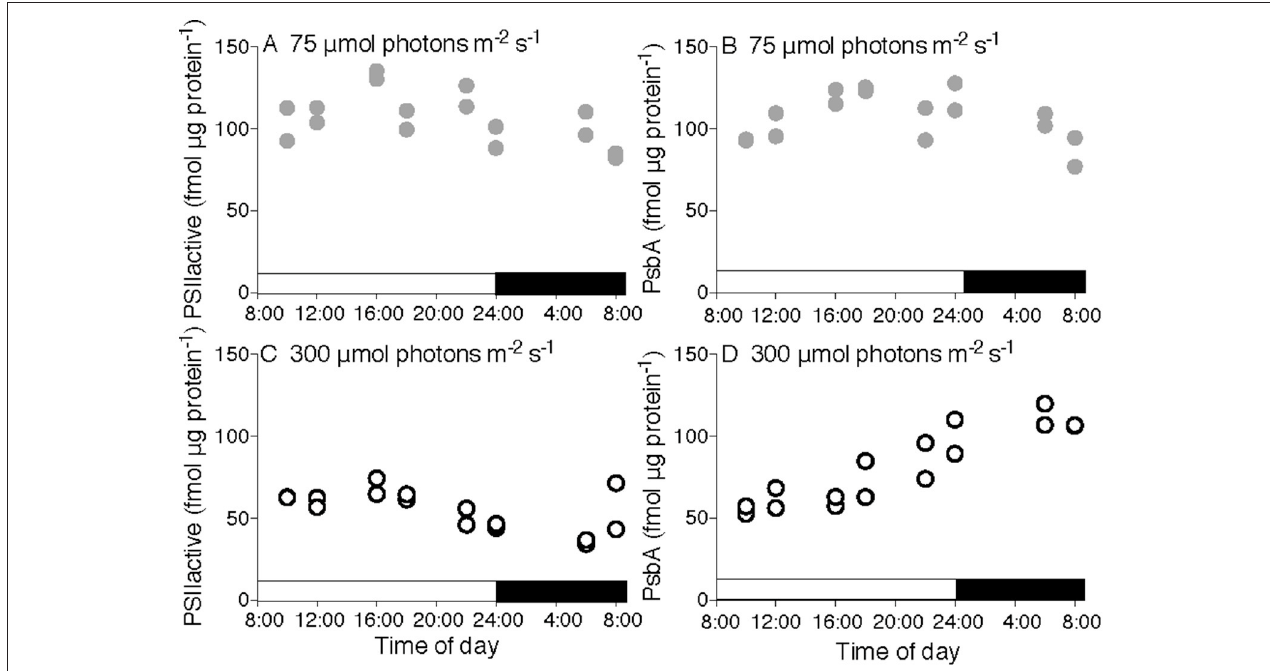
FIGURE 1 | Diel progressions of content of Photosystem II for T. pseudonana . PSII activefluor (A,C) or PsbA protein content (B,D) vs. time of day for cultures growing under 75 (A,B) or 300 µ mol photons m − 2 s − 1 (C,D) with a 16:8 L:D cycle indicated by horizontal bars along X axes. Points show determinations upon two separate cultures for each